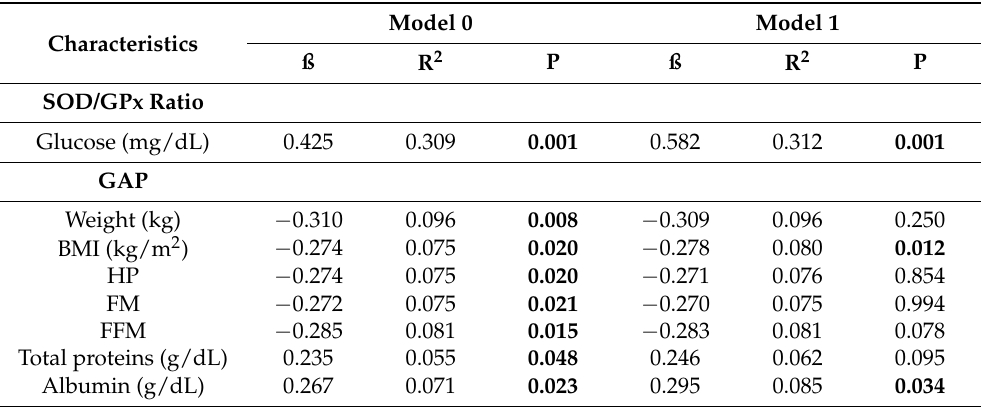
Table 3. Regression analysis between the body composition and biochemical parameters of the study and the SOD/GPx ratio and GAP.